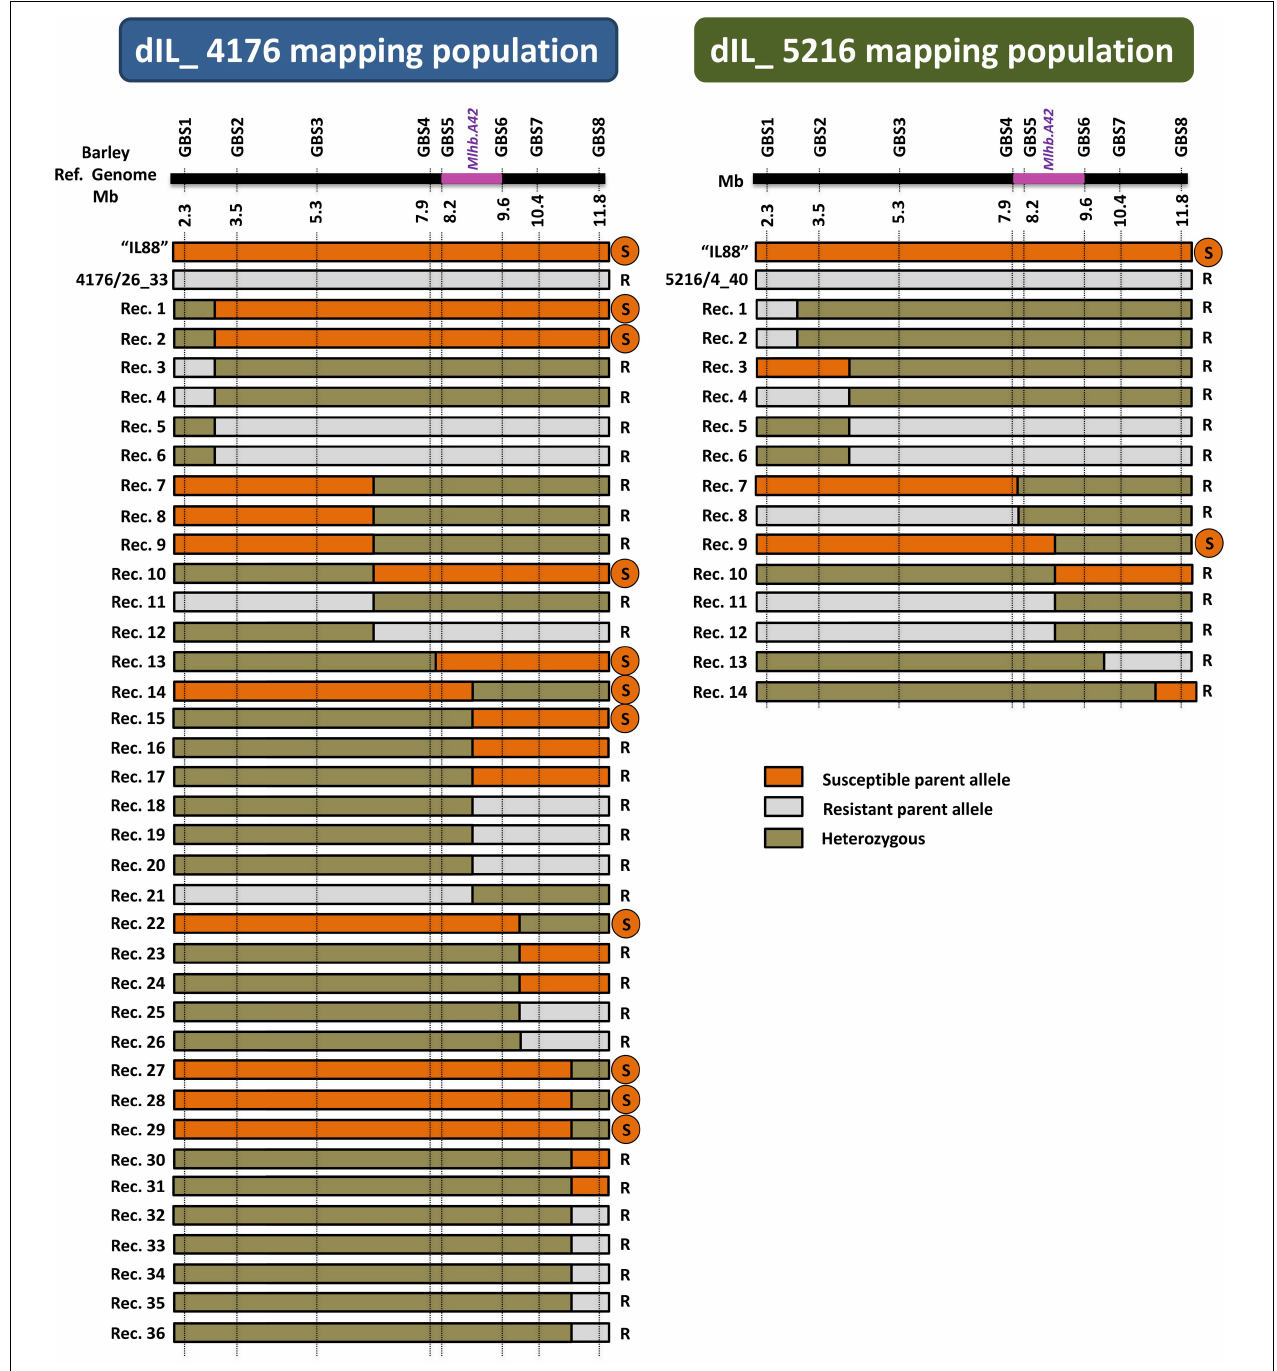
FIGURE 5 | Intraspecific mapping of the powdery mildew resistance locus Mlhb.A42 in F2 populations derived from two different 2HS Hv / Hb introgression lines. The horizontal black bar schematically represents barley chromosome 2HS. The physical coordinates of each GBS marker are indicated below it. The genomic region containing the Mlhb.A42 locus on barley chromosome 2HS is shown in purple. The graphical genotypes of recombinants are indicated as horizontal bars. The genotype of the susceptible parent “IL88” is represented in orange, the one of the resistant parents 4176/26_33 and 5216/4_40 is represented in gray, and heterozygous state is shown in olive green. The phenotype of each recombinant plant is indicated on the right of its genotype (R = resistant; S = susceptible). The recombination rates in “dIL_4176” and “dIL_5216” are 24.7 and 13.6%, respectively, corresponding to a 20-fold increase compared to single introgression lines. The Mlhb.A42 gene was allocated to a 1.4 Mb interval, based on an estimate using the Hv genome as reference.